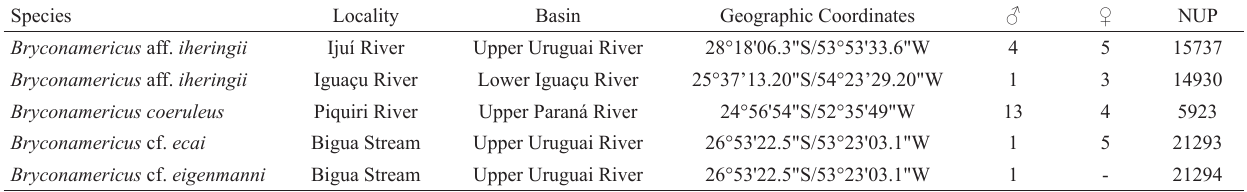
Table 1. Bryconamericus species collected and their collection sites. ♂ = Males, ♀ = Females, NUP = voucher numbers of the Coleção Ictiológica do Nupélia.